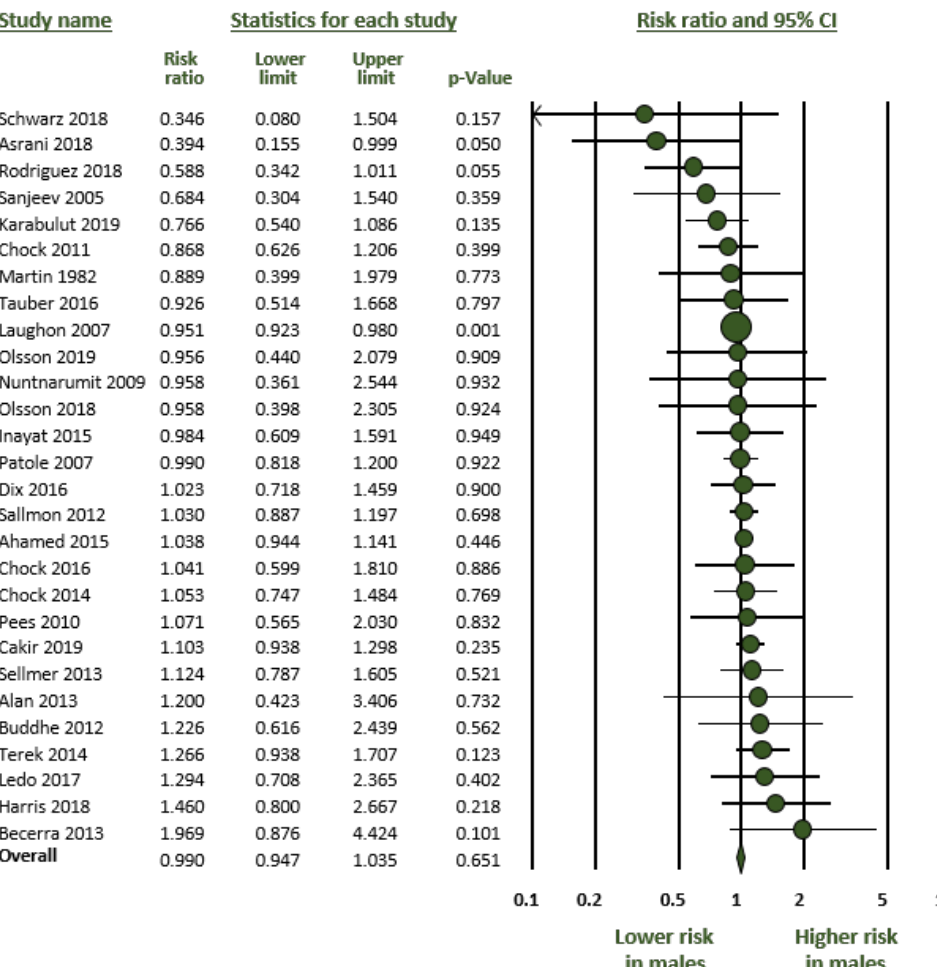
Figure 3. Meta-analysis on the association between sex of preterm newborns and risk of developing hemodynamically significant patent ductus arteriosus (hsPDA). Large ductal shunts were compared with small shunts. The median incidence of hsPDA in the cohorts was 48.3% (range 24.3 to 89.2%). CI: confidence interval; Risk ratio above 1 means higher risk in males.